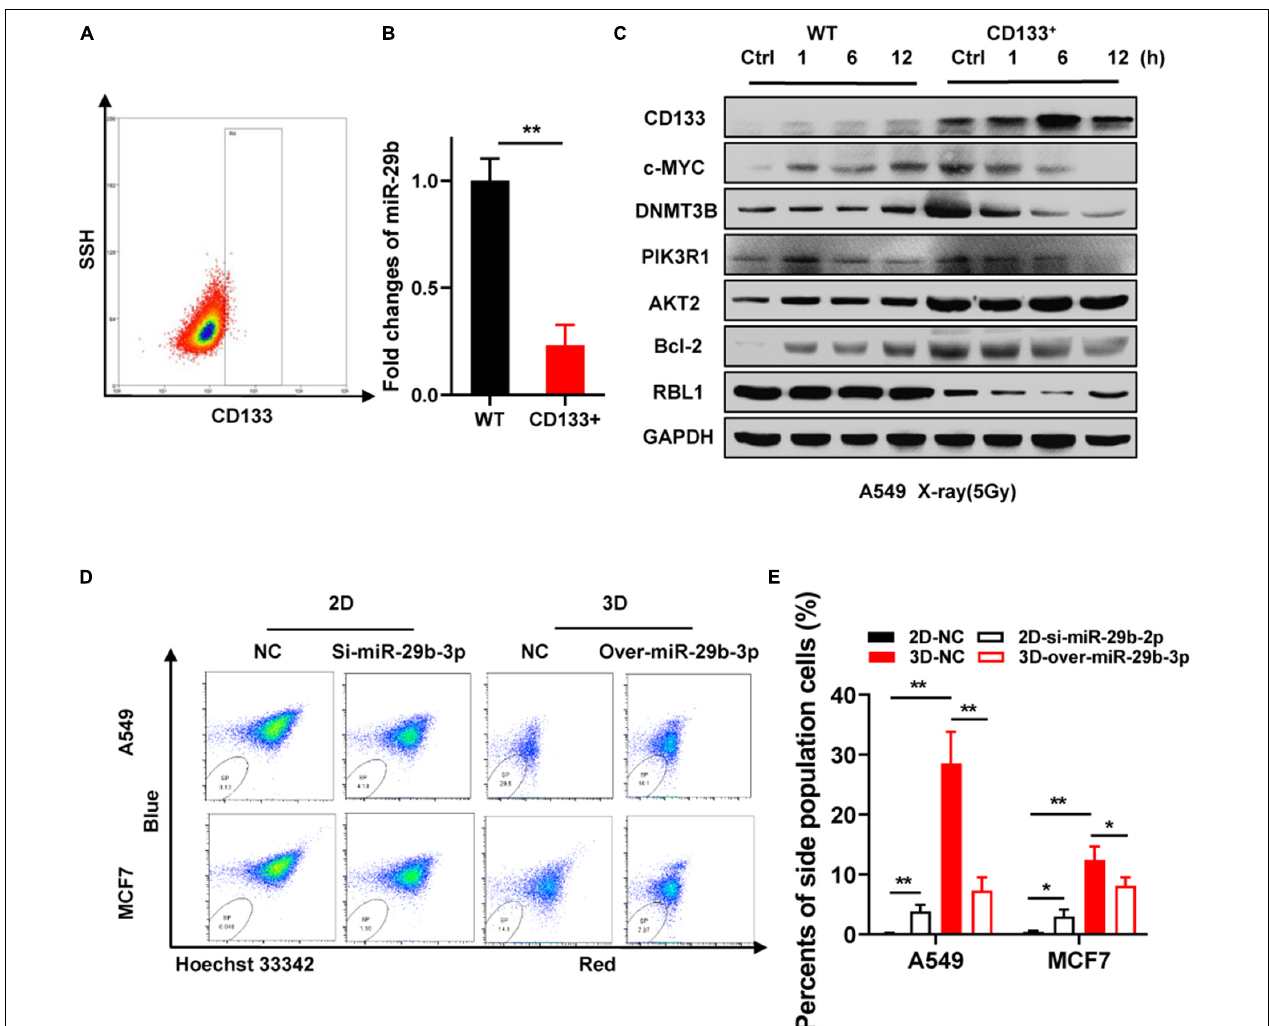
FIGURE 8 | Correlation between miR-29b-3p expression and cancer cell sternness. (A) Sorting CD133+ A549 cells by flow cytometry. (B) Relative miR-29b-3p expression measured by qRT-PCR in CD133+ and negative control A549 cells. (C) Western blot assay on the expression of CD133, c-MYC, DNMT3B, PIK3R1, AKT2, Bcl-2 and RBL1 at indicated time points after 5 Gy X-rays in CD133+ A549 cells and negative control cells. (D,E) Side population in miR-29b-3p knockdown 2D and overexpressed 3D culture A549 cells. Ctrl, unirradiated groups; NC, negative control; WT, wild type groups. Significance was determined by unpaired t -test. * P < 0.05; ** P <